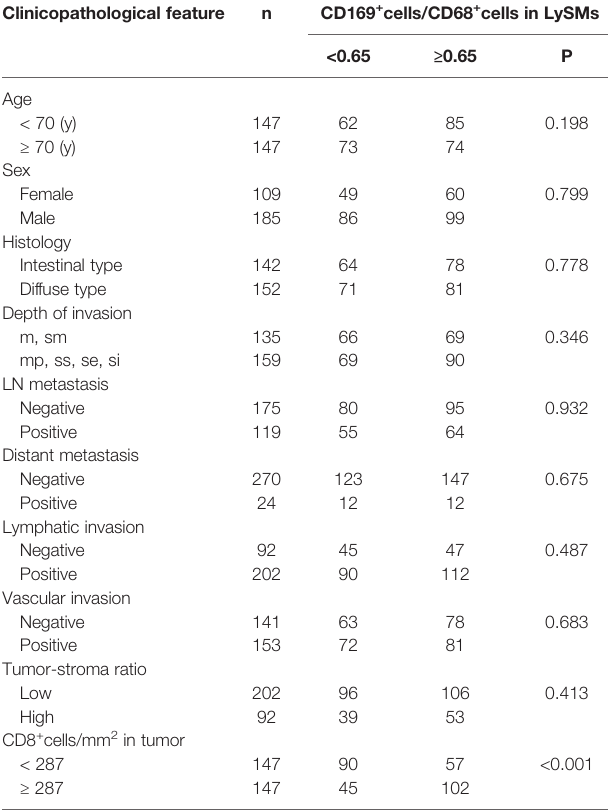
TABLE 1 | Clinicopathological features and CD169 + /CD68 + ratio in lymph node sinus macrophages (LySMs) from 294 patients with gastric cancer. Clinicopathological